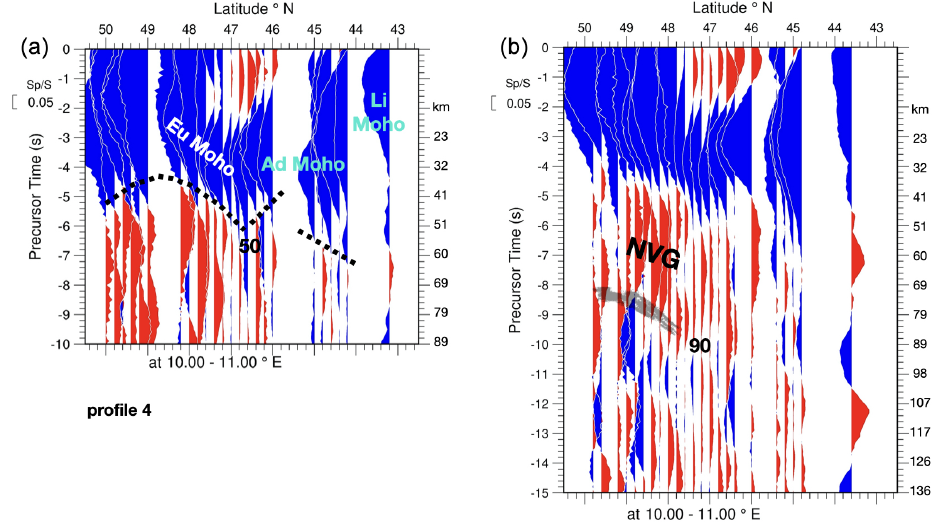
Figure 6. Profile 4. North–south profiles at 10–11 ◦ E. Note that the deepest point of the Moho at 46.5 ◦ latitude closely coincides with the Europe–Adria boundary according to Spada et al. (2013) (see Fig. 2). The base of the much shallower Ligurian Moho depicted in Fig. 2 marked “Li Moho” is visible at around 43.5 ◦